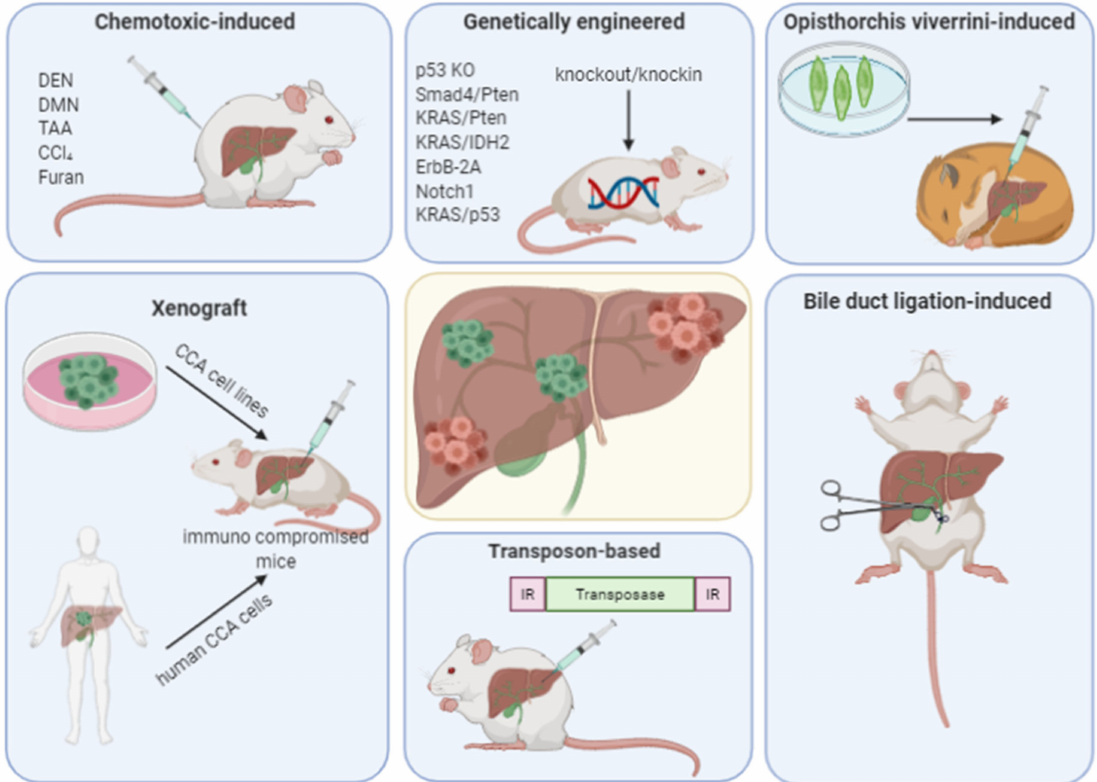
Figure 1. Principles of animal models for cholangiocarcinoma. Some of the di ff erent models can be combined. CCA—cholangiocarcinoma, DEN—diethylnitrosamine, DMN—dimethylnitrosamine, TAA—thioacetamide, CCl 4 —carbon tetrachloride, KO—knockout, IDH—isocitrate dehydrogenase, FGFR—fibroblast growth factor